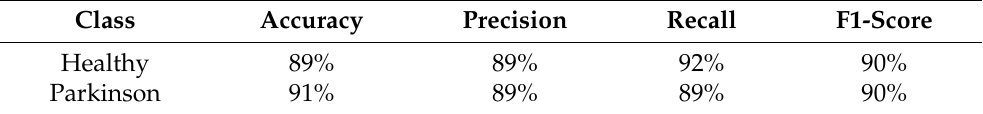
Table 4. Summary of classes performance.